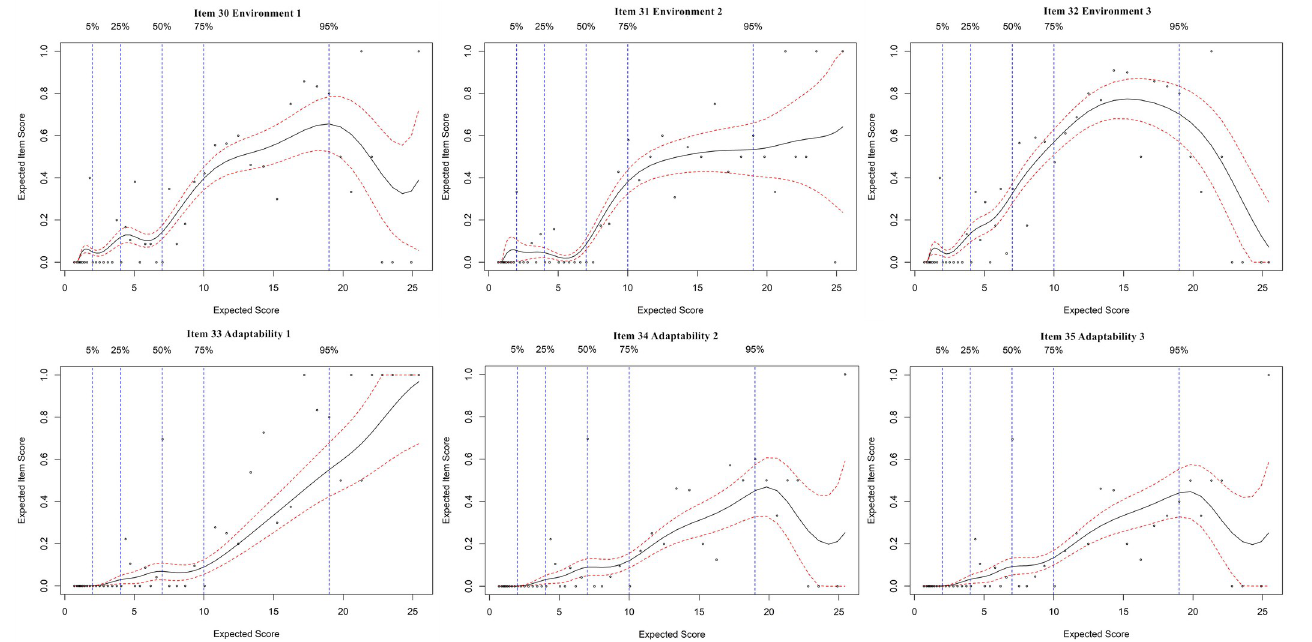
Fig 5. Expected item score curves for environment